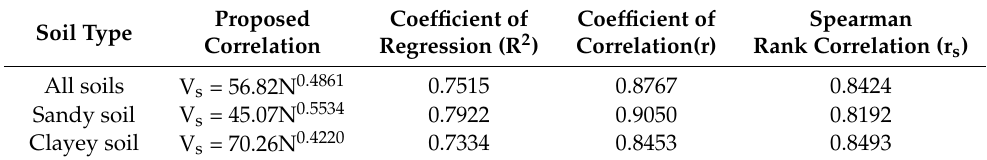
Table 3. Summary of the proposed correlations from this Table 3 . Summary of the proposed correlations from this study.